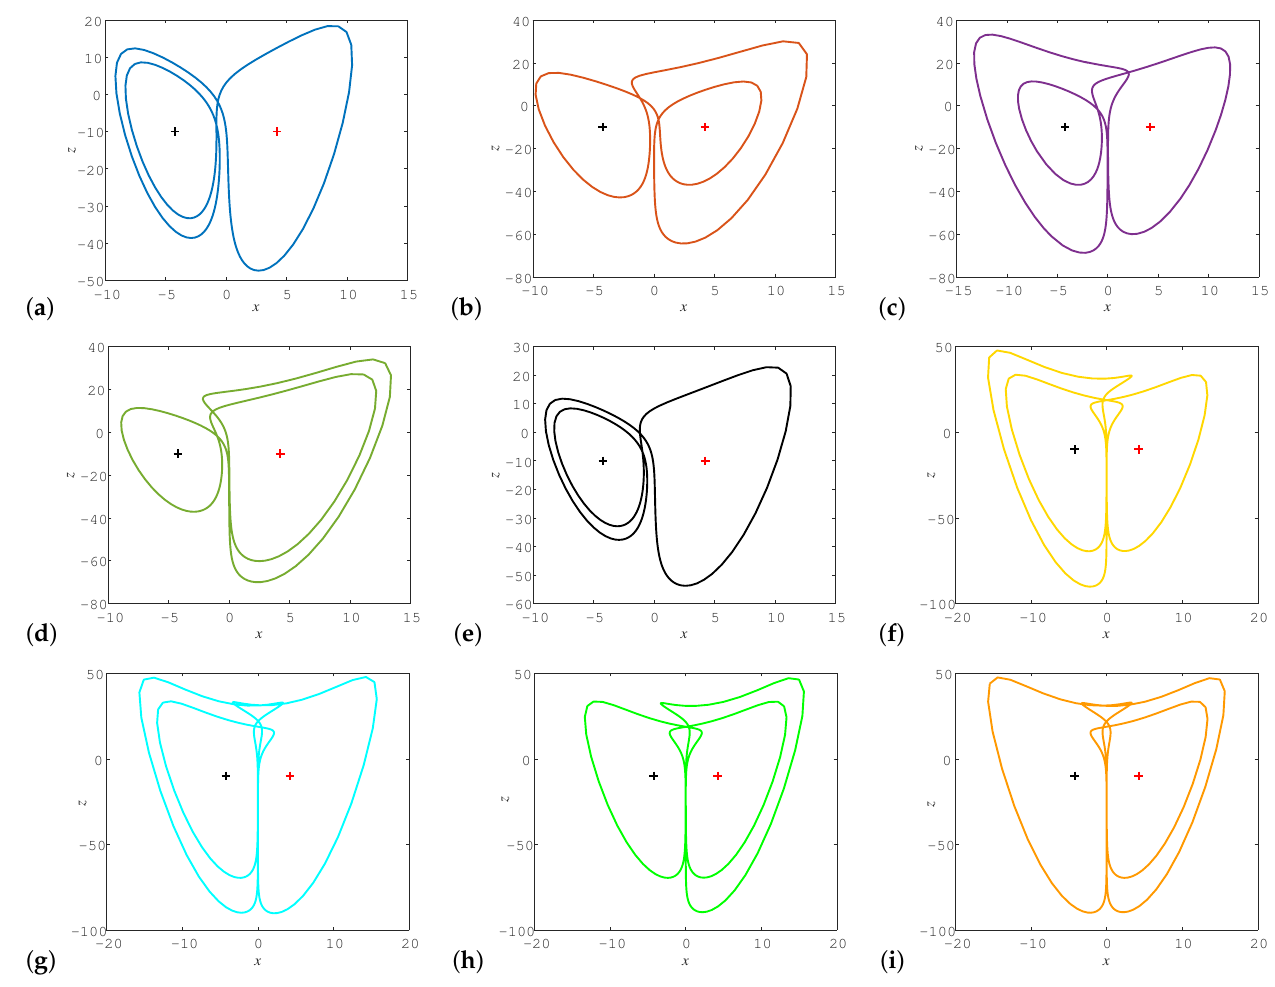
Figure 16. Unstable periodic orbits with a topological length of 3 in the new system, where the two stable equilibria are marked with “+”: ( a ) cycle 001, ( b ) 013, ( c ) 023, ( d ) 033, ( e ) 003, ( f ) 243, ( g ) 245, ( h ) 253, and ( i ) 345. Table 2. Unstable cycles in the new system within a topological length of